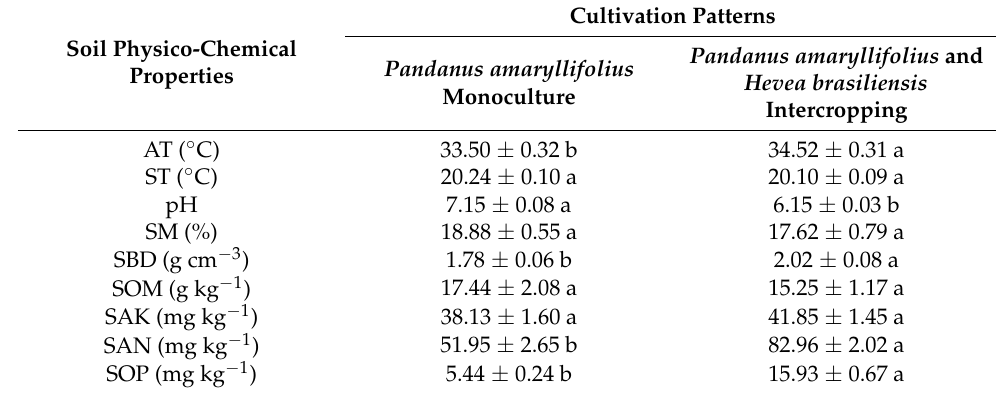
Table 1. Soil physico-chemical properties under monoculture and intercropping patterns.